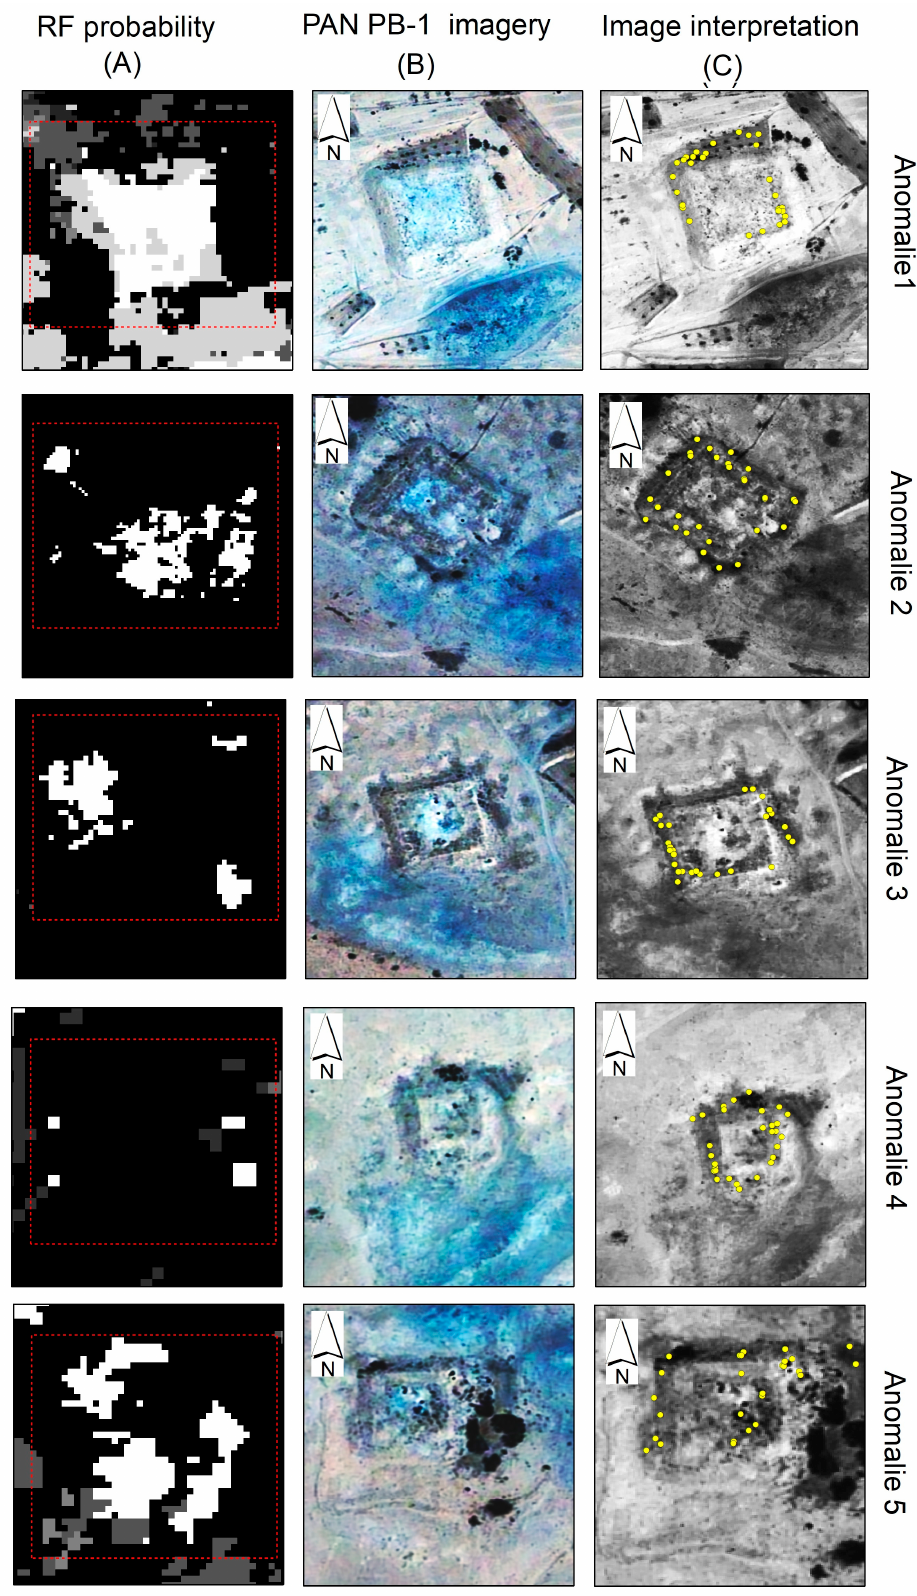
Figure 5. RF probability results. ( A ) Illustration of fortified detection sites. ( B ) Clustering of high- probability pixels in the area showing the detection structures of fortified sites. ( C ) Pan sharpened Pleiades imagery. Image was interpreted as signifying the existence of a fort hidden underground.